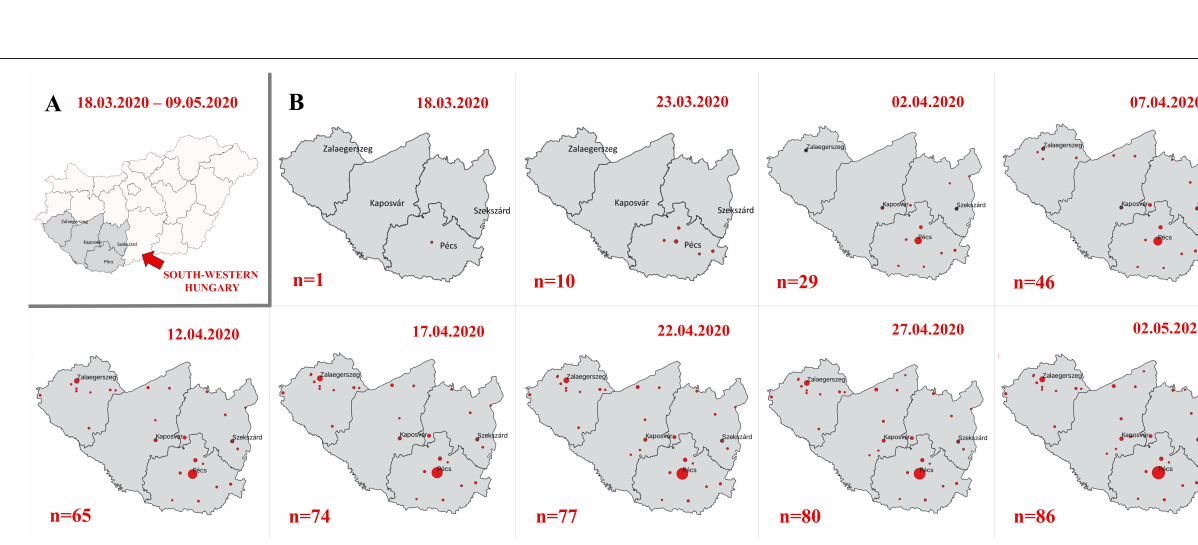
respectively; W = 10, p = 1). 56.3% of the participants tested positive with the first RT-qPCR test among health care professionals with confirmed infection. Contrary to the general population, the viral excretion of infections identified later was not different from those with positive first tests (10,117 ±